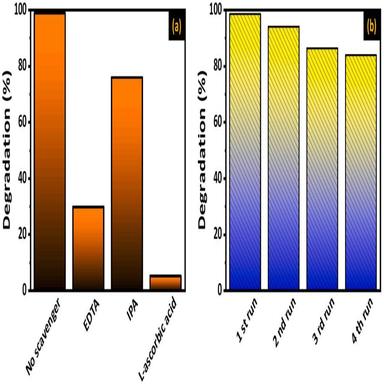
(a) Effect of scavengers agent on the photoelectrocatalytic degradation of RhB, (b) Recycling test of the electrode.